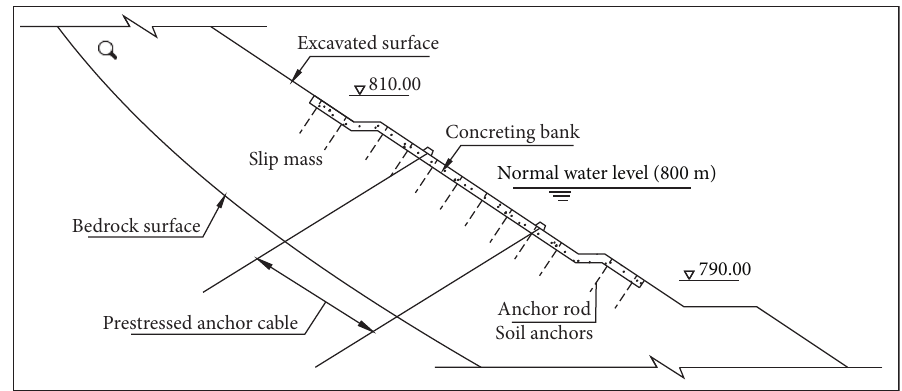
Figure 10: Schematic diagram of water level protection